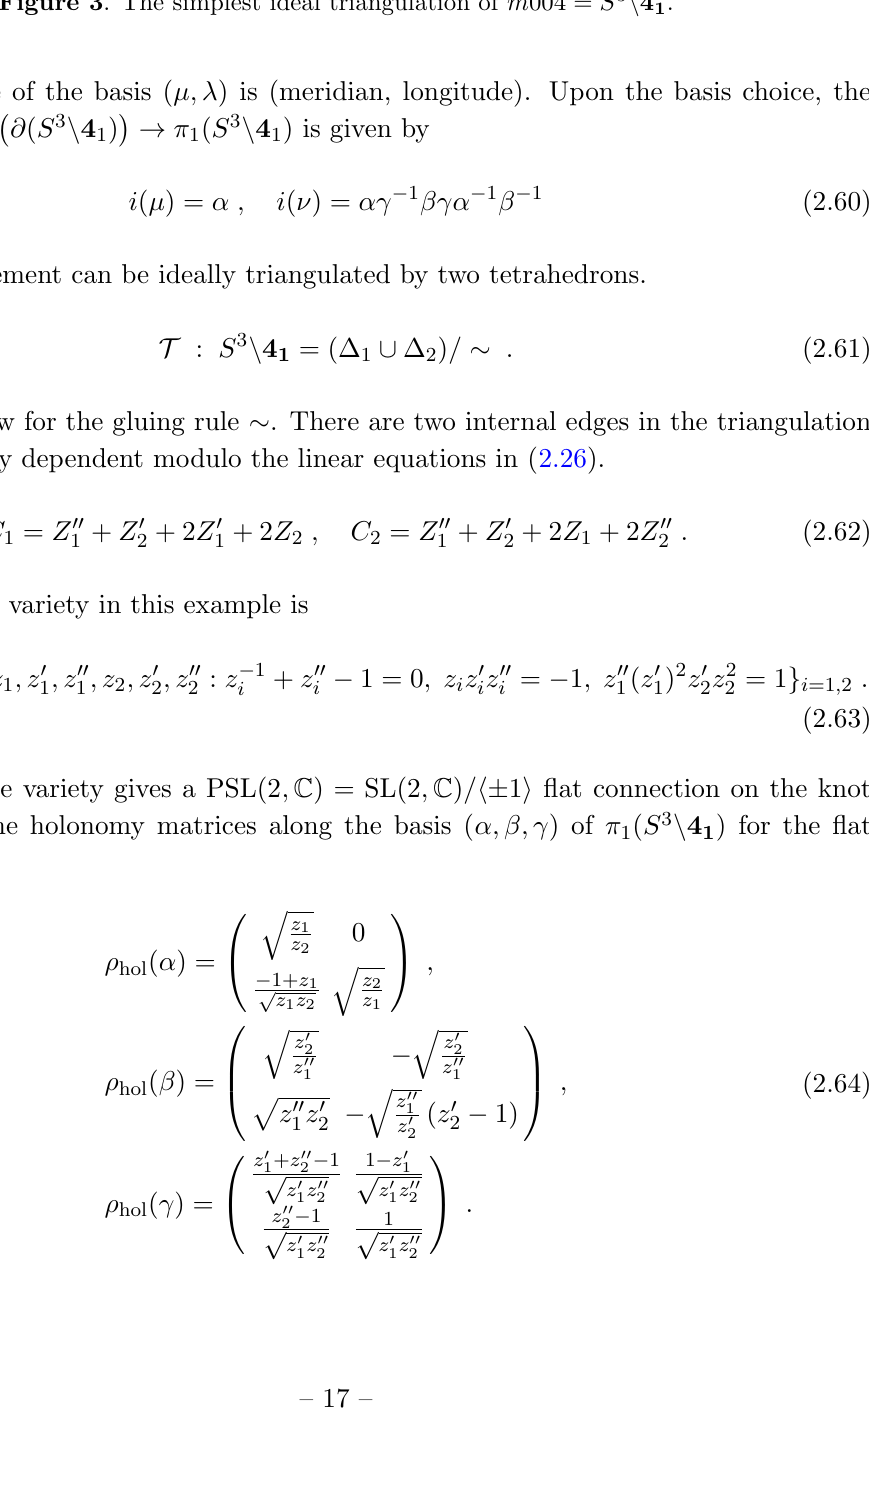
Figure 3 . The simplest ideal triangulation of m 004 = S 3 n 4 1